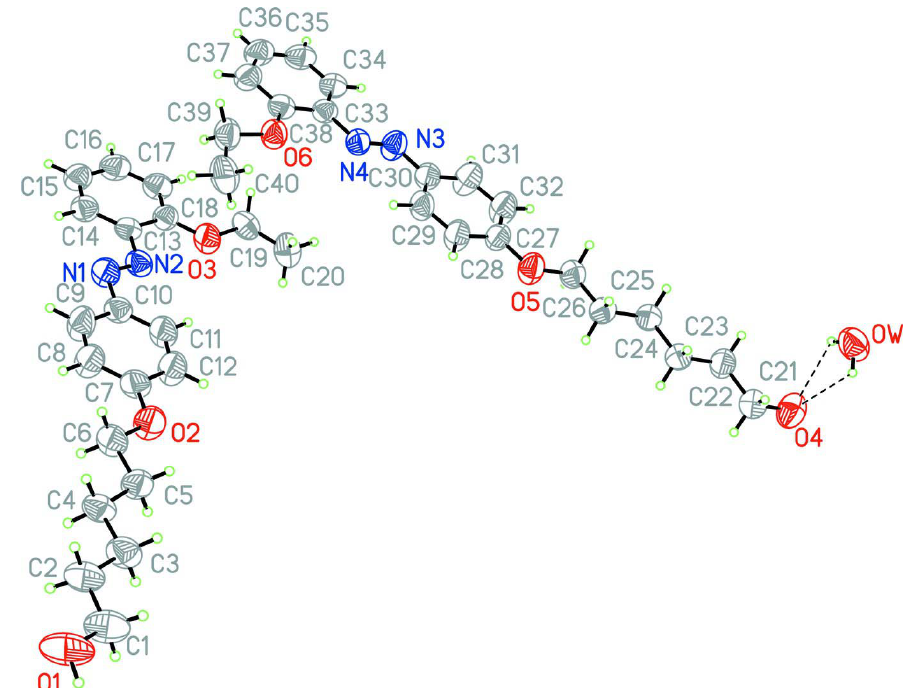
Figure 1 A view of the molecular structure of (I), showing displacement ellipsoids at the 30% probability level. Dashed lines indicate hydrogen